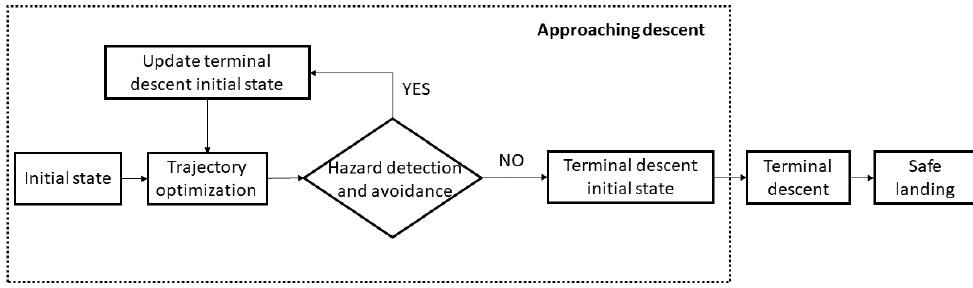
Figure 5. Guidance